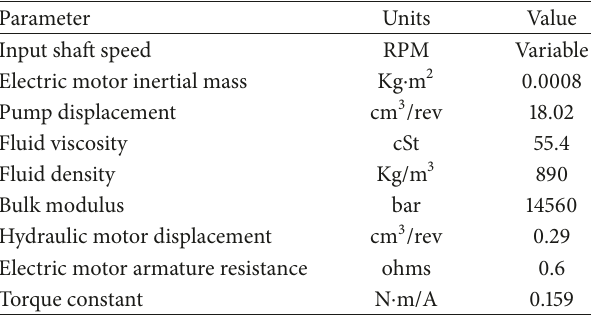
Table 1: Model main parameters.